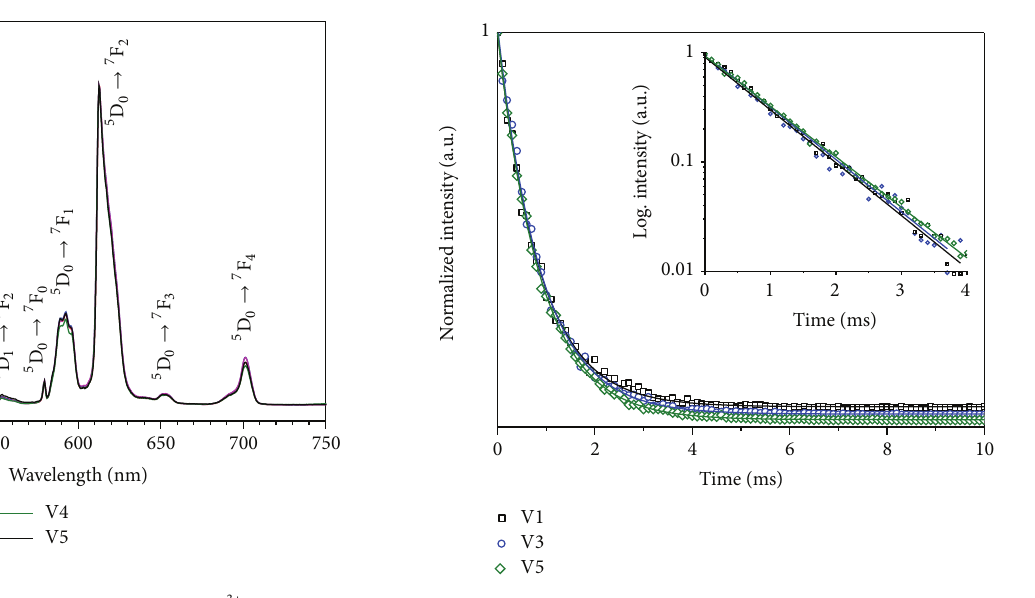
Figure 7: Luminescence decay from the 5 D 0 level of Eu 3+ in ZnO- CdO-TeO 2 :Eu glasses by monitoring the 5 D 0 → 7 F 2 transition at ∼ 615 nm.Insetshowsthevariationoflogarithmicintensitywithtime fitted to a linear function for some